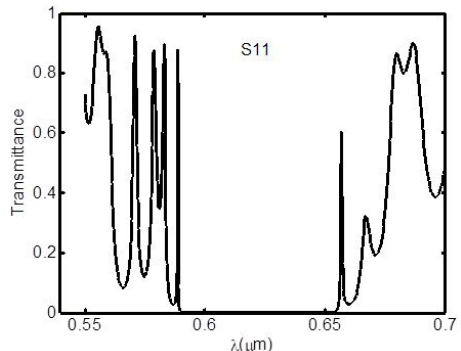
Figure 3. Transmittance spectrum of Fibonacci metamaterial superconductor photonic crystal for